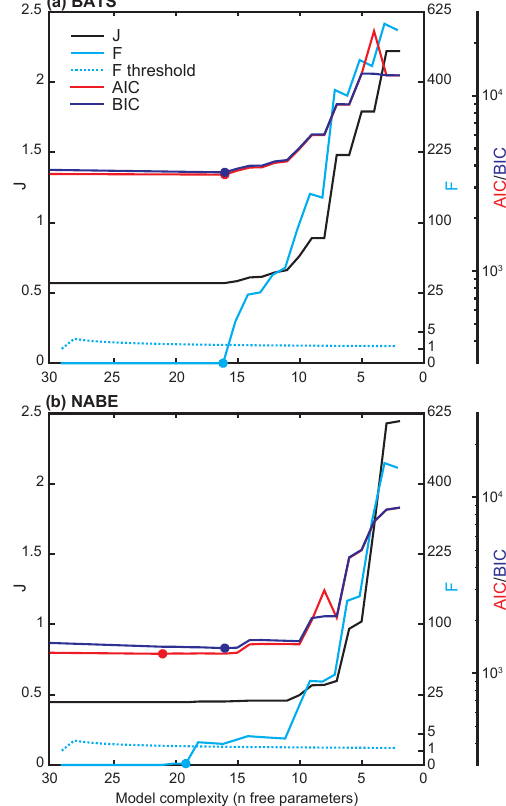
Figure 4. Model selection metrics at sites of the Bermuda Atlantic Time-series Study (BATS) and the North Atlantic Bloom Experi- ment (NABE), as a function of complexity across a suite of nested ocean biogeochemical models (Ward et al., 2013). The least-squares misfit, J (left-hand axis), increases monotonically with decreasing complexity, as it does not penalize model complexity. The likeli- hood ratio test, F (first right-hand axis), compares each reduced model to the full model, and selects the simplest that is not signif- icantly worse than the full model ( F <F threshold). The AIC and BIC (second right-hand axis) both contain terms that account for model data misfit and complexity, and the optimal model is the one with the lowest score. In each case, the optimal model is indicated by a